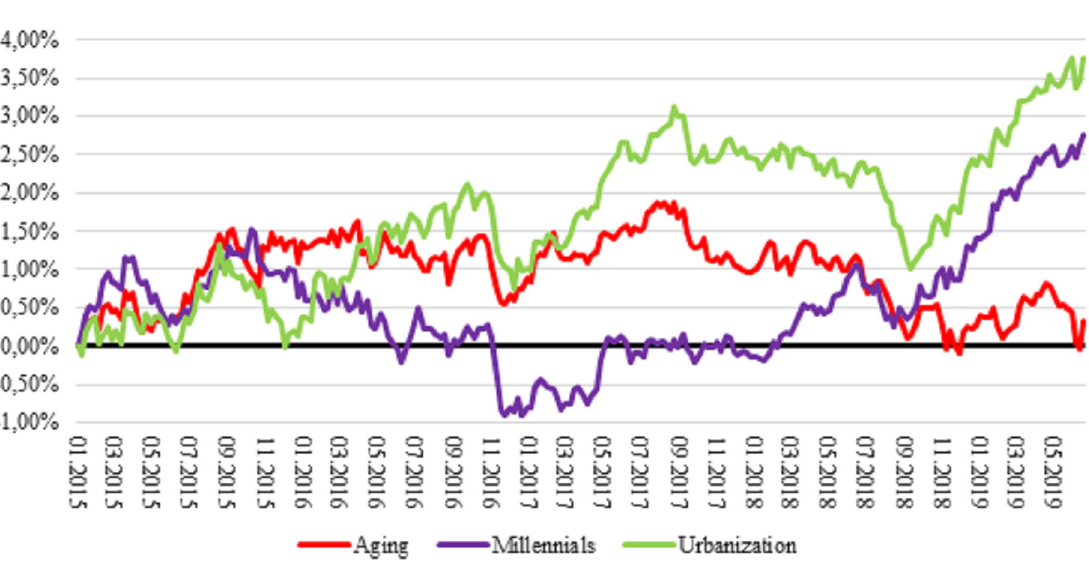
Fig 3. Cumulative market-relative return of social megatrends, 2015–2019. Returns are total log returns. MXWD is the Bloomberg ticker for MSCI ACWI Index.